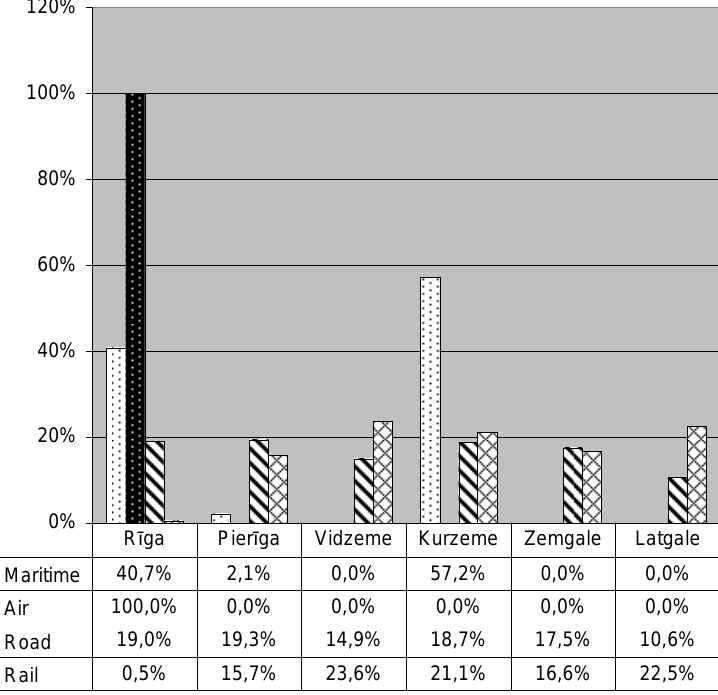
Fig 6. Distribution of cargo flow in percentage out of the total volume by modes of transport in the regions of Latvia in